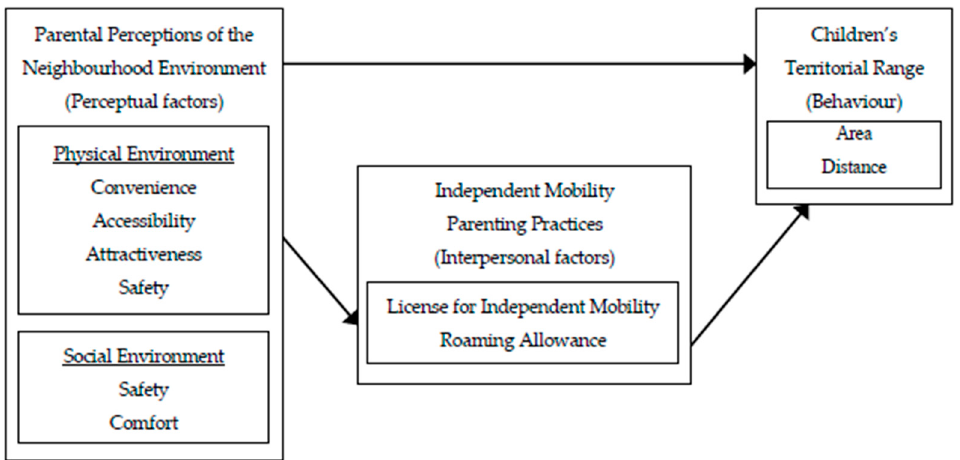
Figure 1. Theoretical model examining how parental perceptions of the neighbourhood environment relate to children's territorial range and mediation by independent mobility parenting